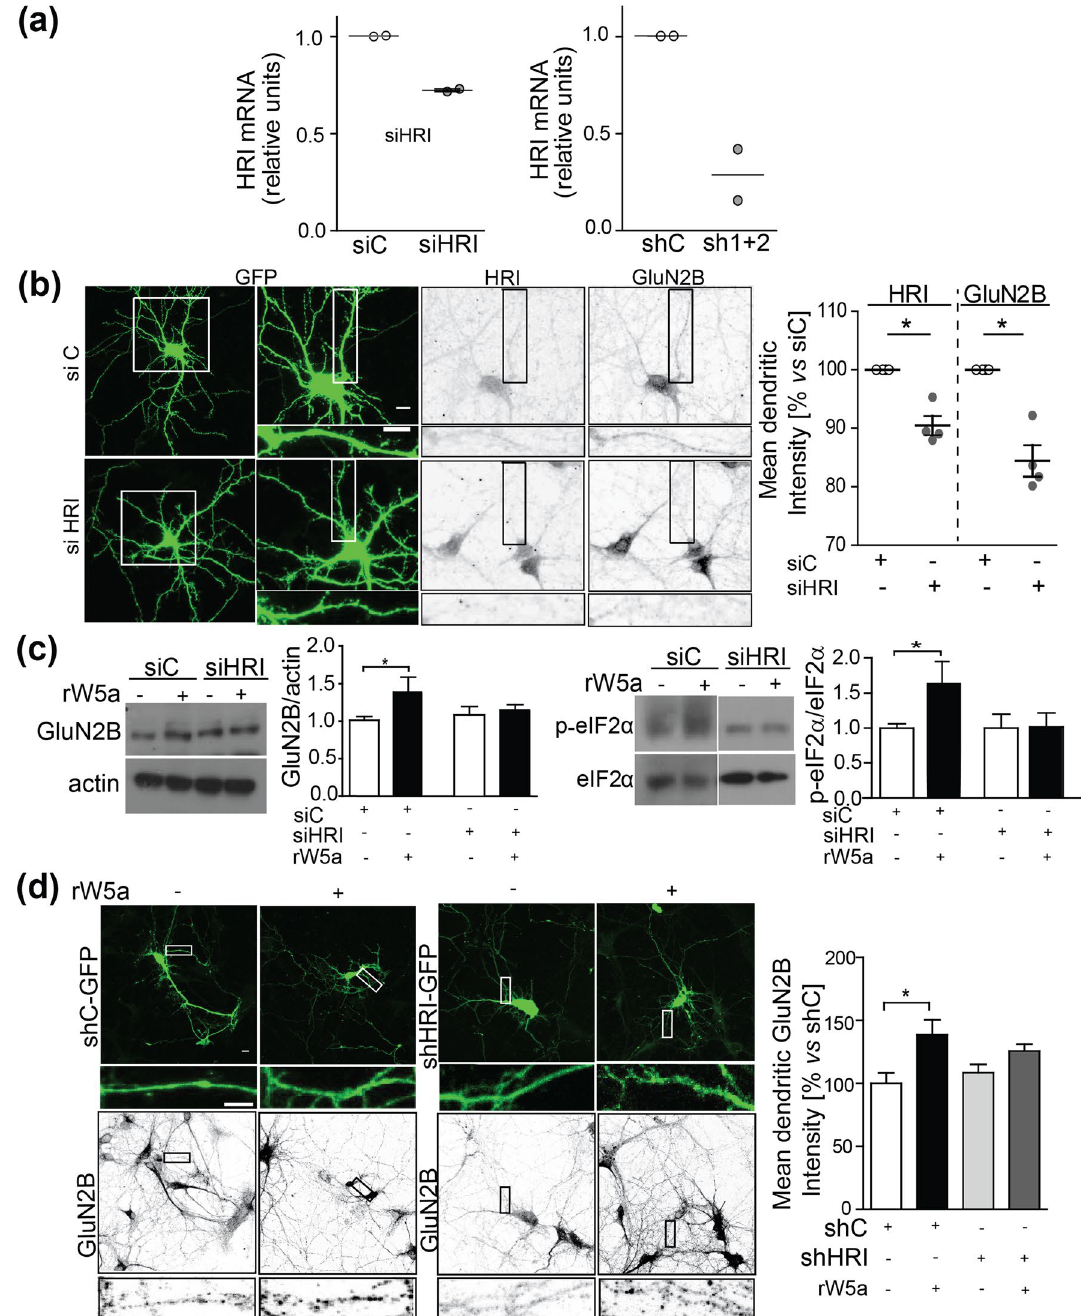
Figure 5. HRI knockdown reduces Wnt5a mediated GluN2B expression. ( a ) qRT-PCR from total RNA isolated from hippocampal neurons after magnetofection with siC and siHRI or infection with shC and sh1+2. HRI mRNA levels were normalized to GAPDH mRNA and are expressed relative to the control condition. Lines show the mean ± SEM N = 2 independent experiments ( b ) Representative images of immunofluorescences from DIV10 hippocampal neurons magnofected at DIV8 with eGFP and siRNA or siHRI, and the respective GluN2B and HRI signals. The right panel show the quantification of N = 4 independent experiments ± SEM ( c ) Representative western blot from hippocampal neurons transfected with siC or siHRI and untreated or treated with 300 ng/mL rWnt5a for 1 h. Graph at right shows the western blot quantifications relative to the control. Bars represent mean ± SEM N = 5. (* p = 0.0254). ( d ) Immunofluorescence detection of the presence of GluN2B in DIV10 hippocampal neurons transfected with bicistronic shC-tGFP or shHRI-tGFP at DIV6-7. Graph quantifying the mean GluN2B intensity in hippocampal dendrites. Bars show the mean ± SEM. N = 3 independent experiments. shC (55); shC+rWnt5a (43); shHRI (115); shHRI+rWnt5a (151) (* p = 0.0069). Full- length blots are presented in Supplementary Fig.